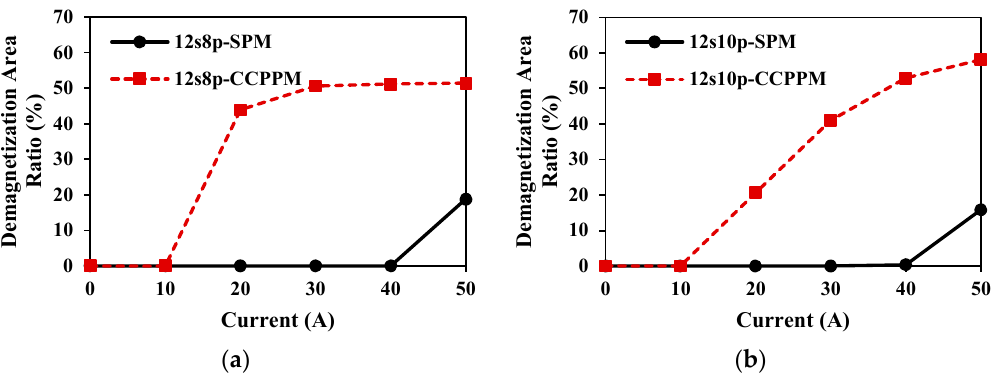
Figure 24. Demagnetization area ratios with negative D-axis current. ( a ) 12s8p machines. ( b ) 12s10p machines.